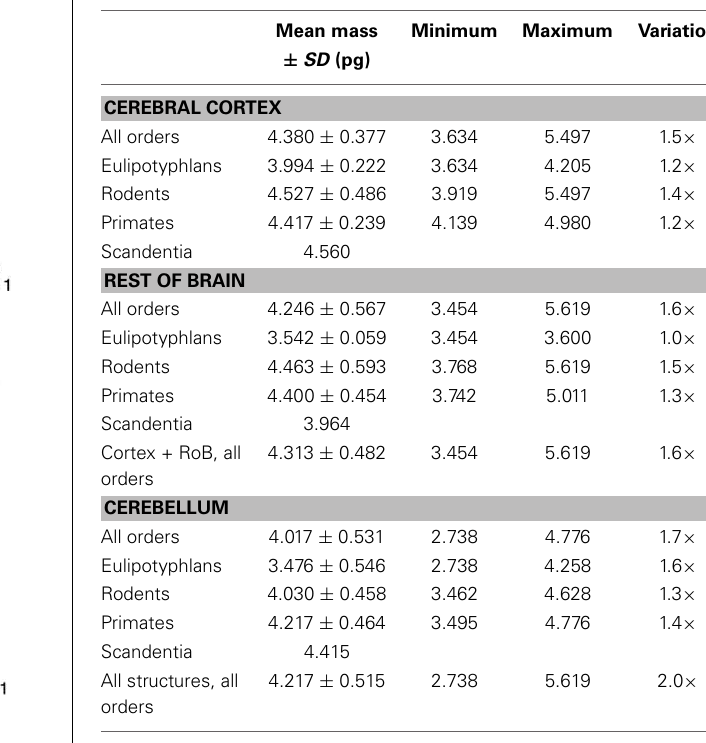
Table 3 | Predicted average glia cell mass in mammalian brain